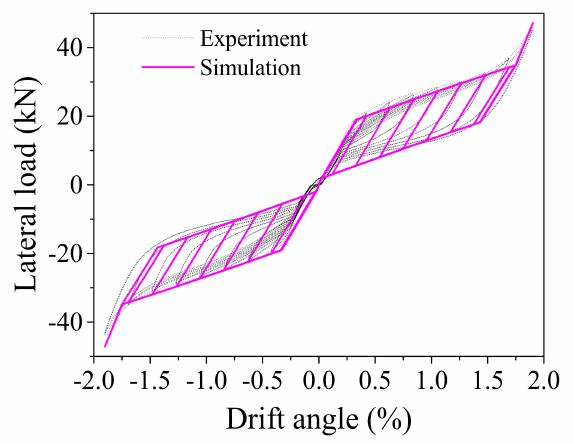
Figure 11. Comparison between numerical simulation and test